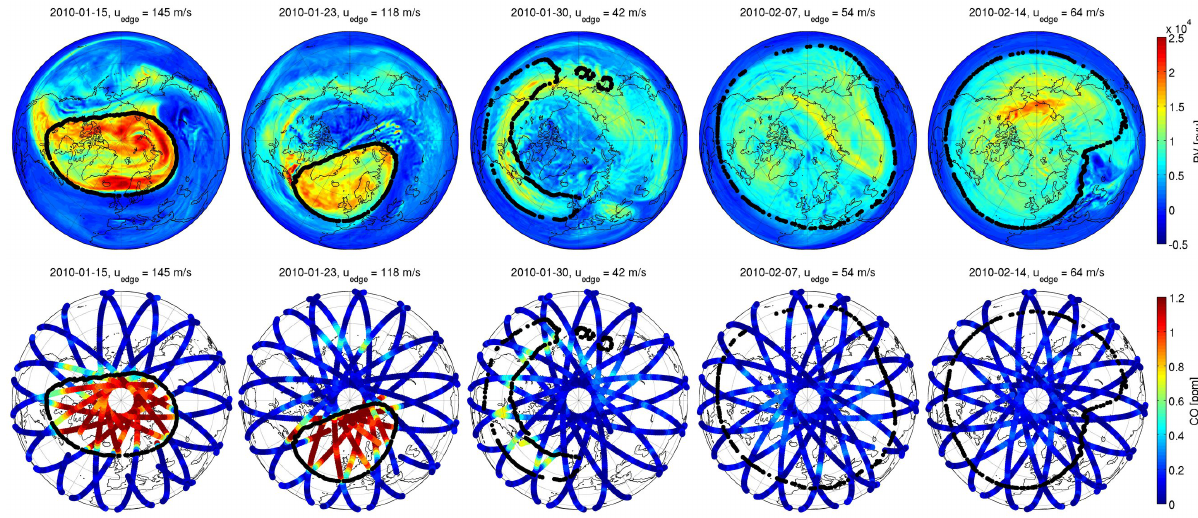
Fig. 2. As in Fig. 1, but on the 1800K isentropic surface (approximately 1hPa) and showing Aura MLS CO VMR [ppm] instead of H 2 O in the lower